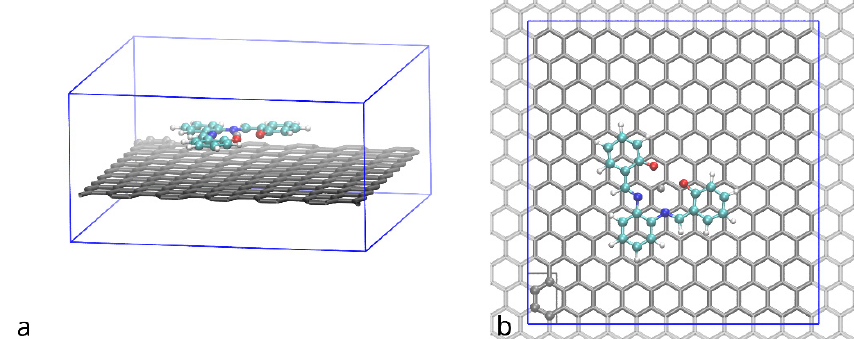
Figure 2. Supercell of graphene (grey tubes) with adsorbed (Zn)salphen compound (ball&stick, color by element) used in DFT simulations: ( a ) side view, ( b ) top view. Periodic image of the graphene beyond the simulation region (blue box) lattice is shown with light grey. Graphene atoms shown with ball and stick representation enclosed in a grey rectangle indicate a rectangle unit cell of a graphene lattice.